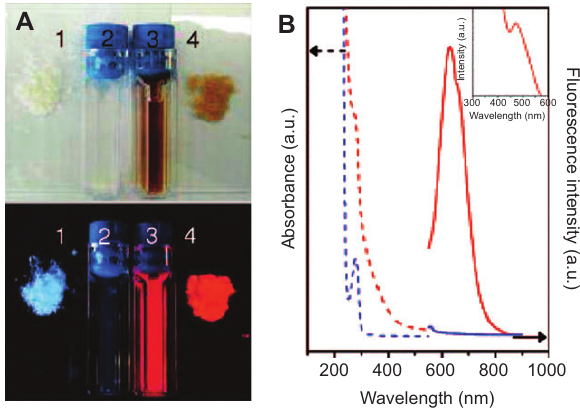
Figure 2 (A) Photographs of BSA (1) powder and (2) aqueous solution and BSA-AuNCs (3) aqueous solution and (4) powder under (top) visible and (bottom) UV light. (B) Optical absorption = 470 nm) spectra (dash lines) and photoemission (solid lines, λ ex of aqueous solution of BSA (blue) and BSA-AuNCs (red). The inset shows the photoexcitation spectrum of BSA-AuNCs. From Ref. [76]